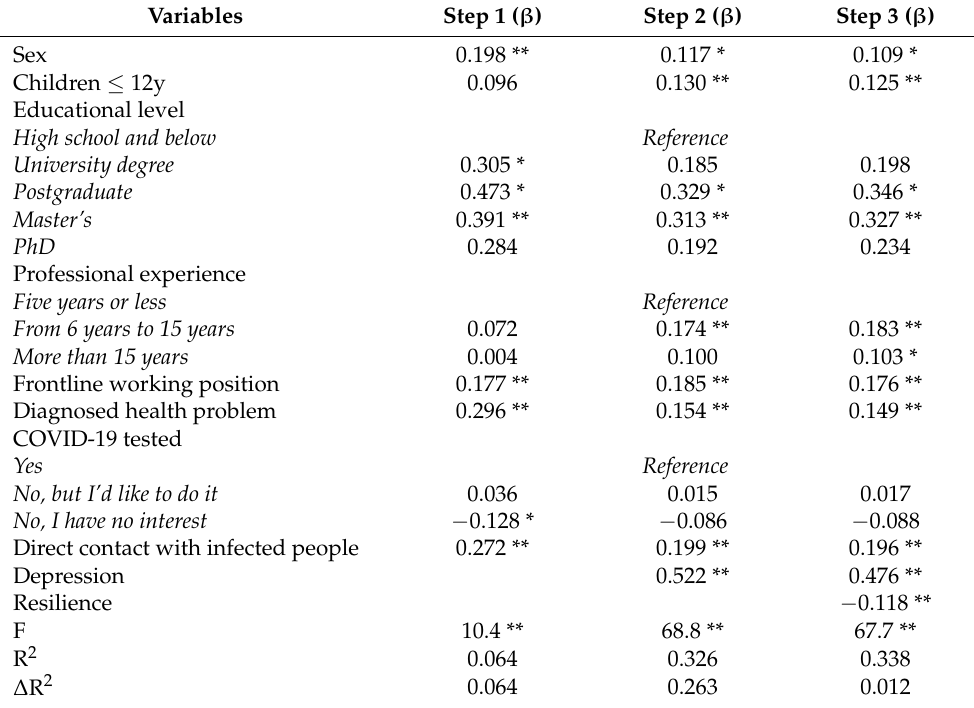
Table 3. Hierarchical linear regression analysis results (outcome variable: work-related